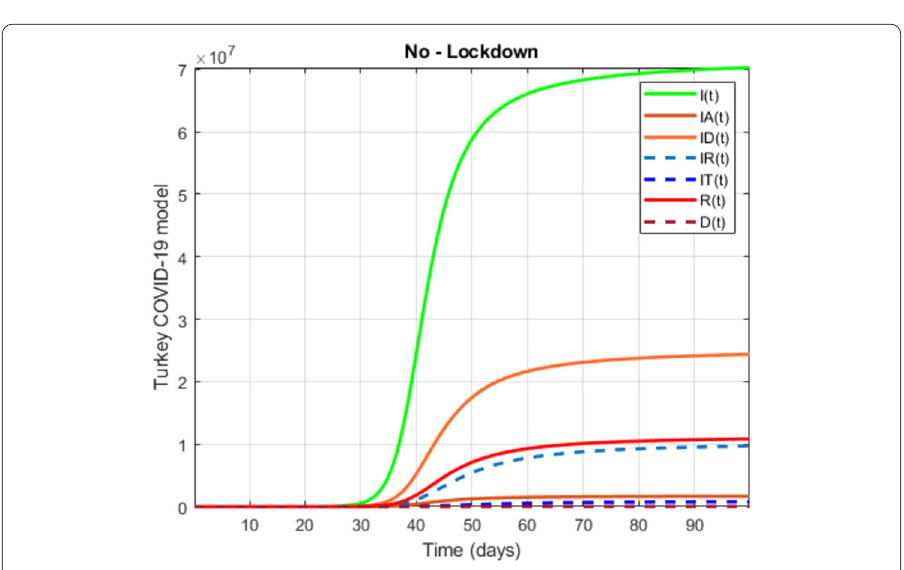
Figure 39 Numerical visualization for Covid-19 model in Turkey for α =